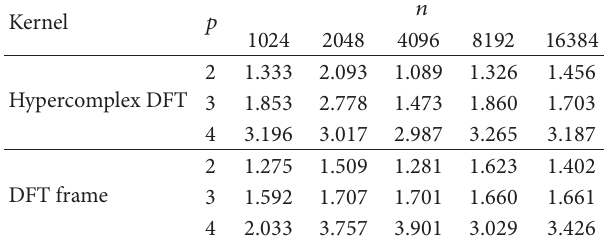
Table 2: Speedup of Algorithm 2.